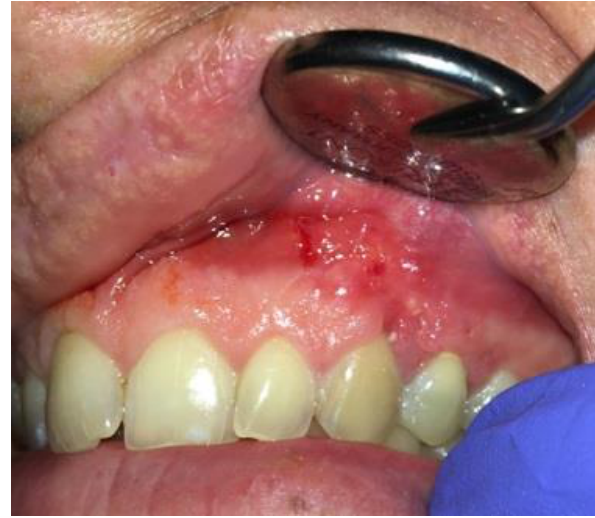
Figure 10. Intraoral photograph 14 days after surgery.